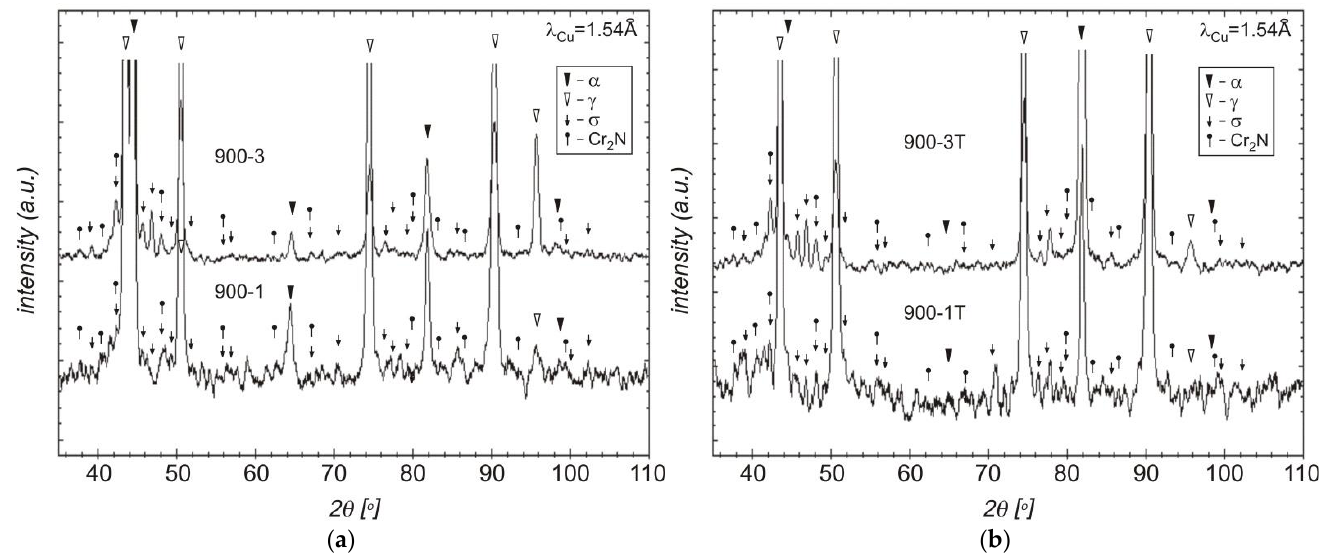
Figure 9. Diffractogram of tested cast steel after holding at 900 °C for 1 and 3 h: ( a ) traditional etching; ( b ) deep etching (T in denotations).